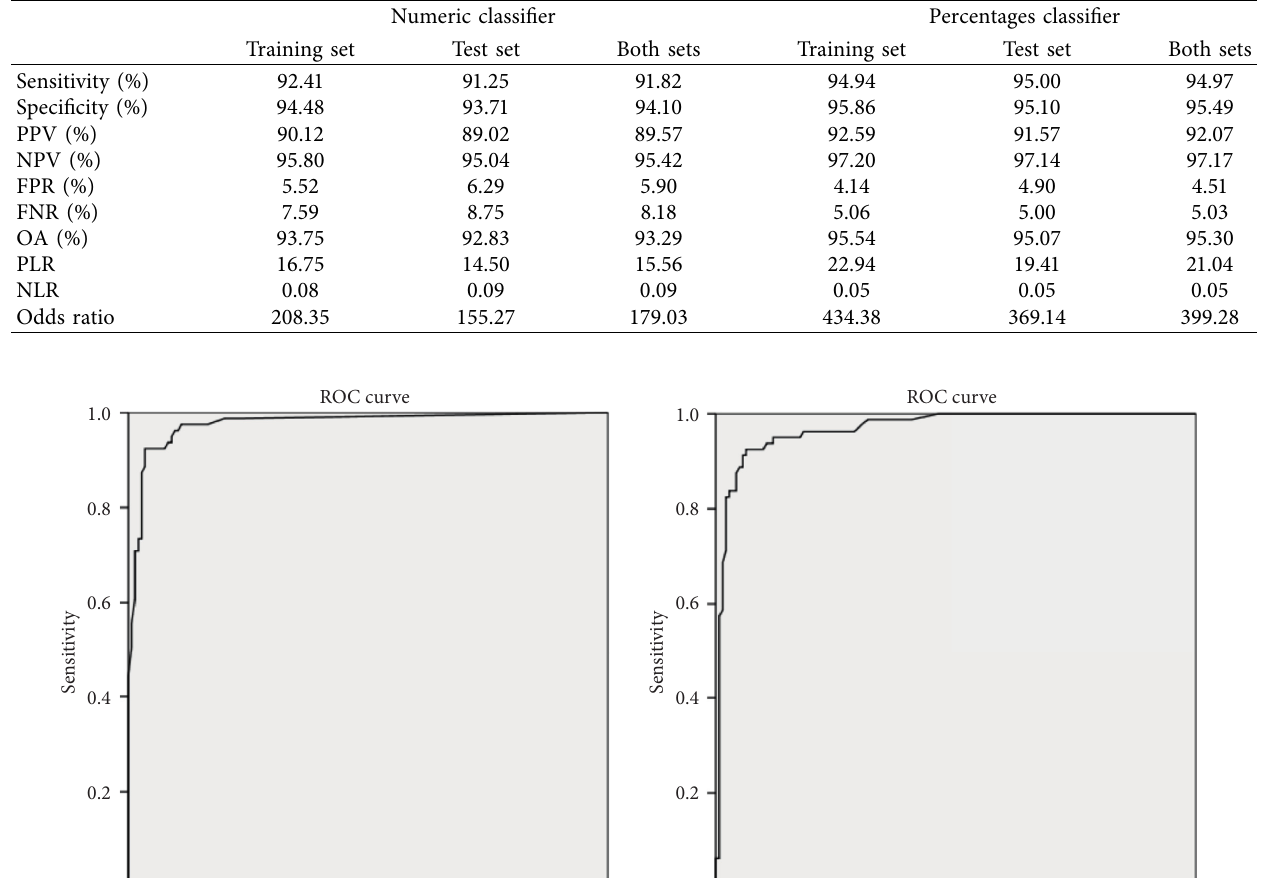
Table 7: Performance indices for the patient classification subsystems (numeric and percentages classifiers) for the training and test sets and for both sets combined.